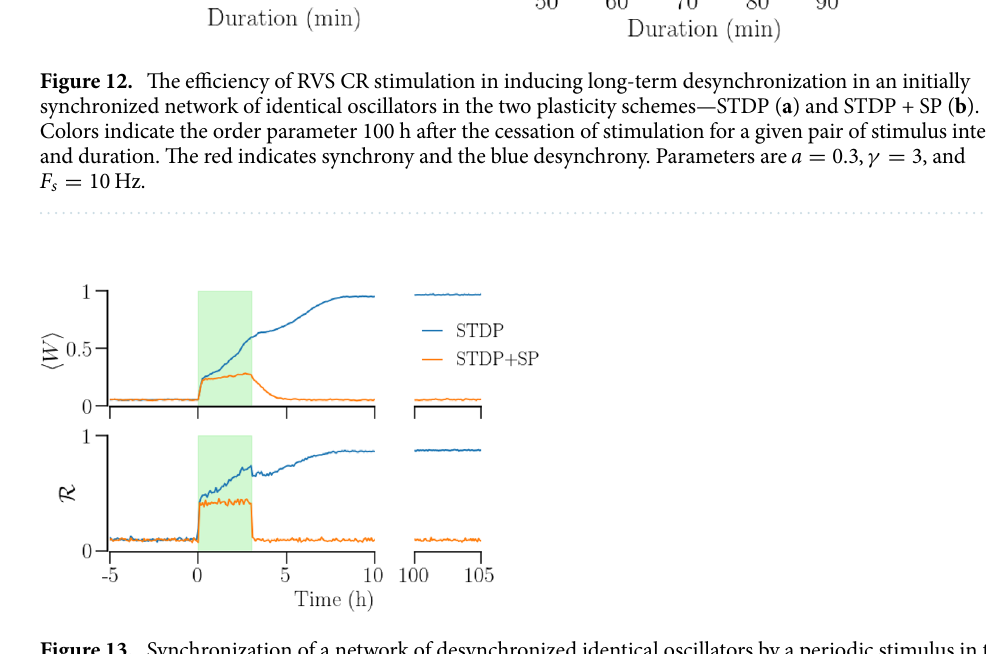
Figure 13. Synchronization of a network of desynchronized identical oscillators by a periodic stimulus in the two plasticity schemes, STDP and STDP + SP. The mean synaptic weight, (cid:31) W (cid:30) , (top) and the order parameter, R , (bottom) show the synchronization of a network with STDP while the network with STDP + SP goes back to desynchrony upon cessation of stimulation. The shaded region highlights the time interval of stimulation. Parameter are: a = 0.3 , γ = 3 ; stimulus parameters are duration = 3 h, I s = 100 , and F s = 10